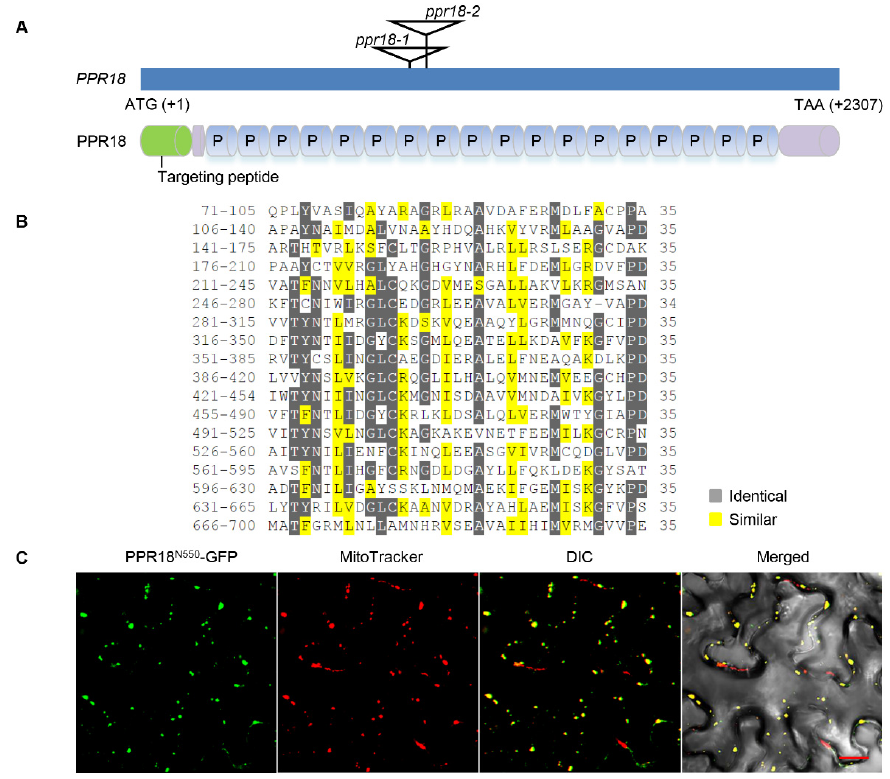
Figure 1. PPR18 is a mitochondrion-localized P-type pentatricopeptide repeat (PPR) protein. ( A ) Schematic illustrating the genomic structure and protein structure of PPR18. The locations of the Mu insertions are marked with triangles in two independent alleles. P, P-type PPR motif. ( B ) Alignment analysis of 18 PPR motifs in PPR18 protein. Identical amino acids are highlighted in dark gray and similar ones in yellow. ( C ) Localization of PPR18 N550 -GFP in tobacco mesophyll cells. Green fluorescence, red fluorescence, and yellow fluorescence (merge) show green fluorescent protein (GFP) fluorescence, MitoTracker stained mitochondria, and localization, respectively. DIC, differential interference contrast. Scale bar, 20 μ m.